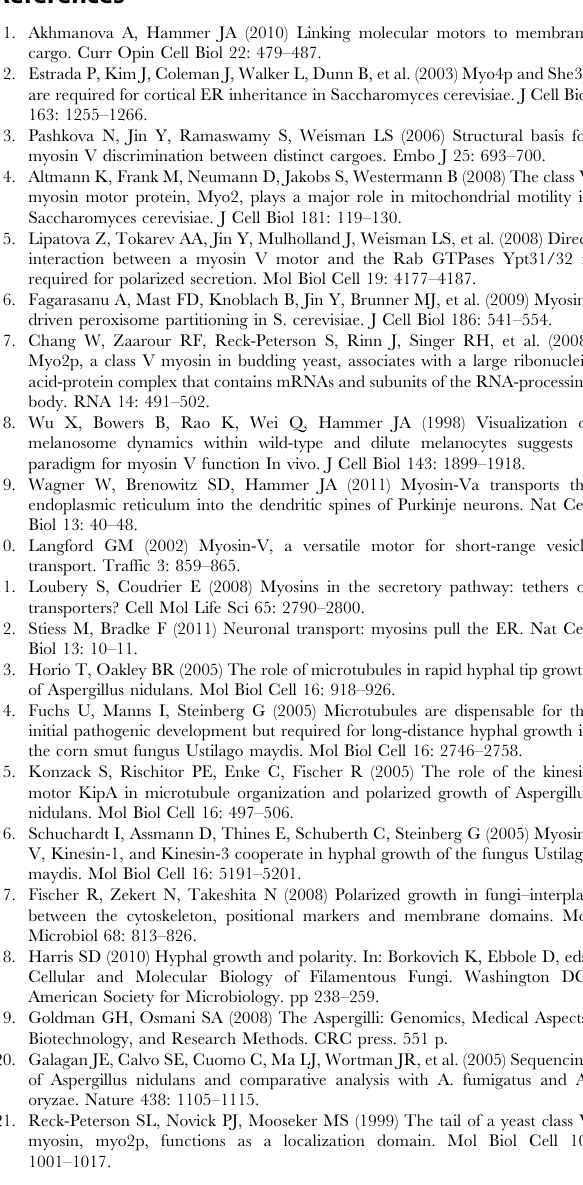
Figure S1 Sequence comparisons among myosin V proteins from mouse and three fungal species. Upper: Sequence alignments of the C-terminal cargo-binding domains